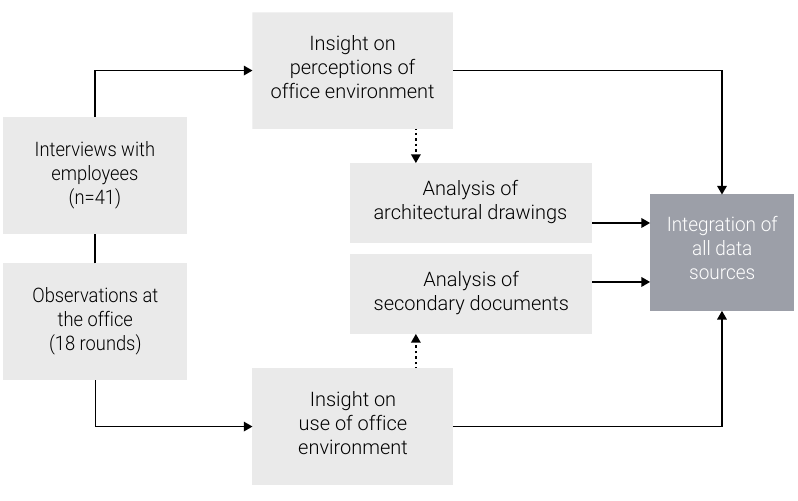
Figure 2. Research